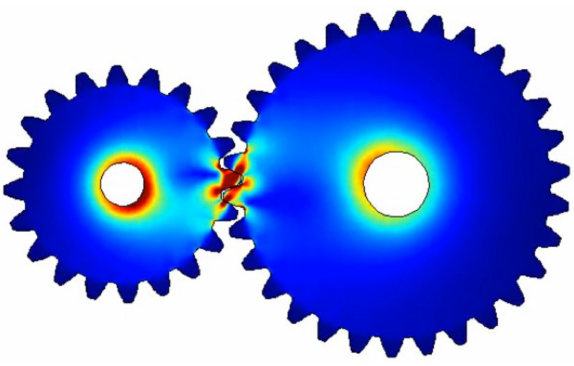
Figure 9. Zones of maximum stress concentration when rotating the